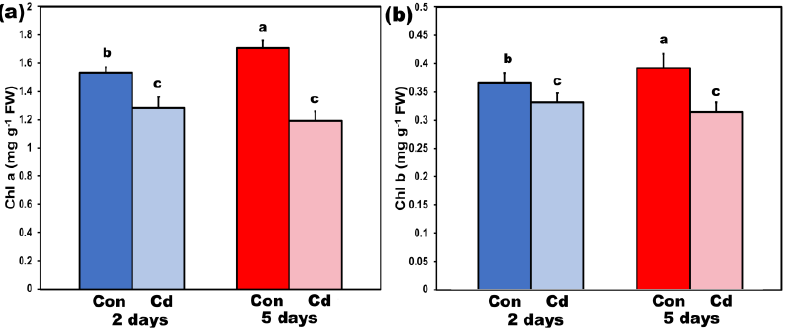
Figure 3. Chlorophyll a content ( a ) and chlorophyll b content ( b ), in mg g −1 fresh weight, of control (con) and 2- and 5-days Cd-treated Salvia sclarea plants. Error bars are standard deviations ( n = 6). Columns with different letters are statistically different ( p < 0.05).